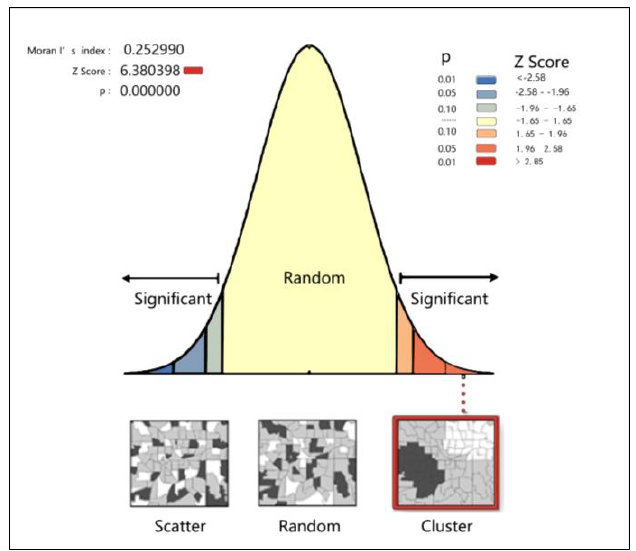
Figure 5. Spatial autocorrelation analysis of rail transit station area accessibility.